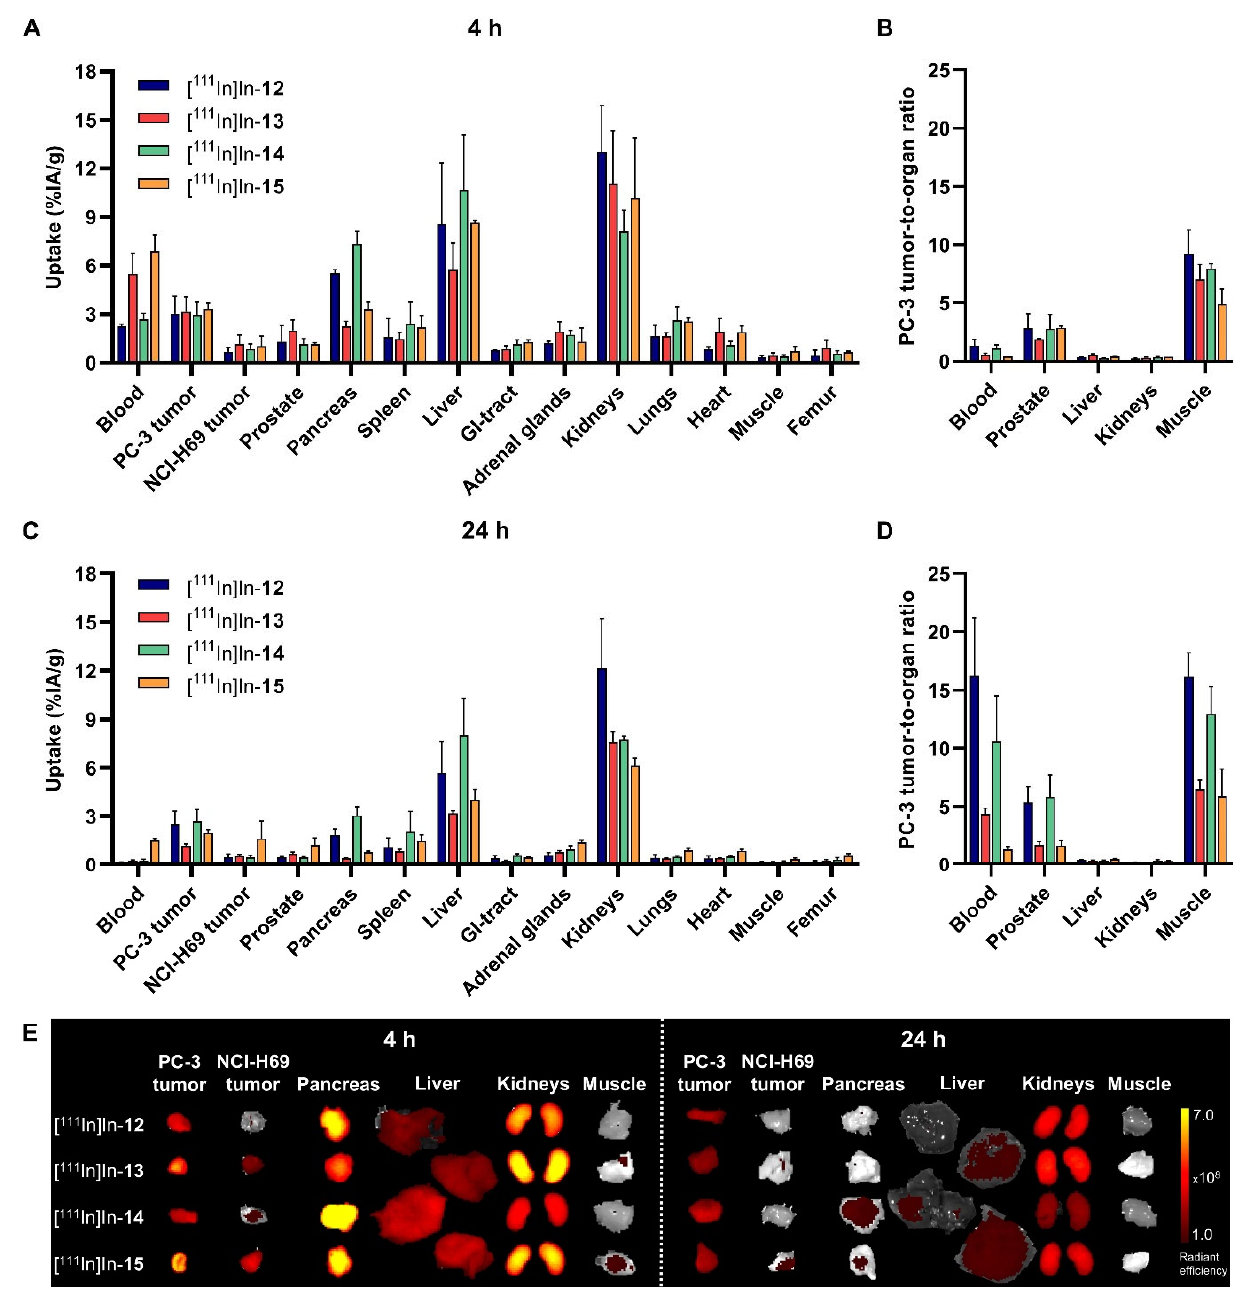
Figure 2. Ex vivo biodistribution of [ 111 In]In- 12 - 15 (20 MBq/1 nmol) in mice bearing GRPR-positive PC-3 and GRPR-negative NCI-H69 xenografts. Radioactivity uptake values are expressed as percentage injected activity per gram of tissue (%IA/g) and as PC-3 tumor-to-organ ratios at 4 h ( A , B ) and 24 h ( C , D ) post injection, and represent the mean ± standard deviation ( n = 3/4). Ex vivo merged photograph and fluorescence images of a subset of dissected tissues and organs ( E ) are shown for one representative mouse per group. The fluorescent signal is displayed as average radiant efficiency in p/sec/cm 2 /sr per µW/cm 2 .